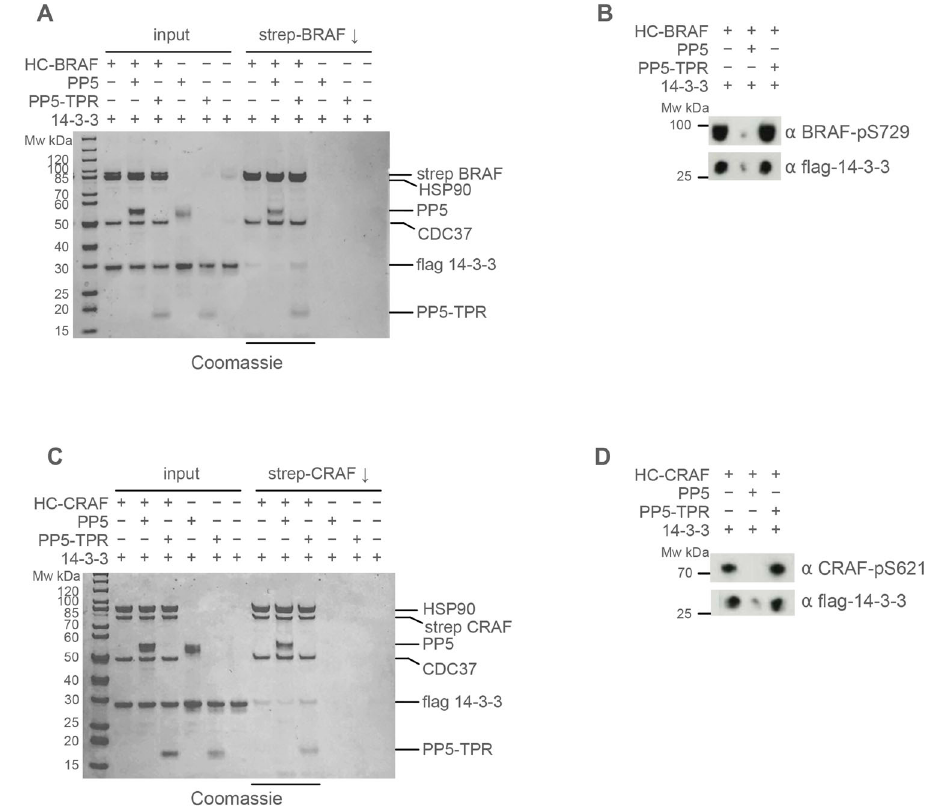
Fig.5|TargeteddephosphorylationbyPP5regulates14-3-3bindingtokinases. A . Puri fi ed HSP90 – CDC37 – BRAF V600E complex is able to co-precipitate fl ag-tagged 14-3-3 protein when the complex is pulled down on a strep-tag at the N-terminus of the kinase. The co-precipitated band is visible on a Coomassie-stained gel (under- linedlanes),andveryclearlyinaWesternblotdevelopedwithanantibodyto14-3-3. B Addition of PP5 substantially diminishes the levels of 14-3-3 co-precipitated, con- sistentwithitsabilitytodephosphorylatethephosphorylationsitesthatmediate14-